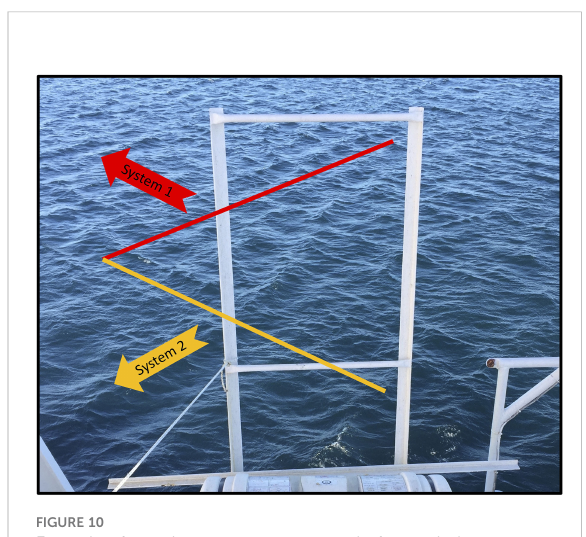
FIGURE 10 Example of crossing sea state composed of two wind sea systems travelling at a near-orthogonal angle recorded with stereo cameras from an oceanographic vessel on 28 March 2017 (photo credit: Andrea Bergamasco,